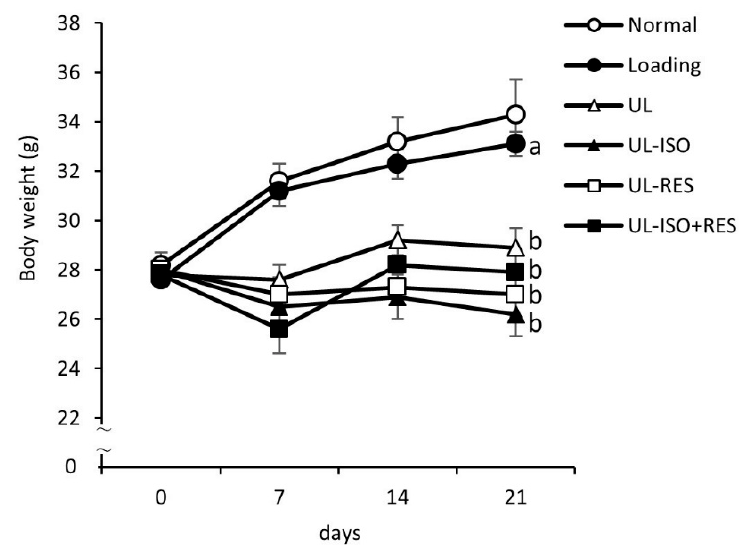
Figure 1. Body weight in hindlimb-unloading mice. Normal, normally housed group; Loading, loading group; UL, hindlimb-unloading mice fed a control diet; UL-ISO, hindlimb-unloading mice fed a 0.16% soy-isoflavones conjugates diet; UL-RES, hindlimb-unloading mice fed a 0.15% RES diet; UL-ISO + RES; hindlimb-unloading mice fed a 0.16% soy-isoflavones conjugates and resveratrol diet. Values are the mean ± SEM ( n = 6–8). The data were analysed using one-way analysis of variance (ANOVA). The Normal group was not included in the statistical analyses. Differences among the groups were assessed by Tukey’s post hoc test. If variances were not equivalent, the data analysed Kruskal–Wallis ANOVA, and followed by a Steel-Dwass test. Differences were considered significant when P < 0.05. a, b Mean values with unlike letters were significantly different. Table 2. Body weights, food intake, and plasma total protein and albumin concentration in mice. UL- Normal Loading UL ISO